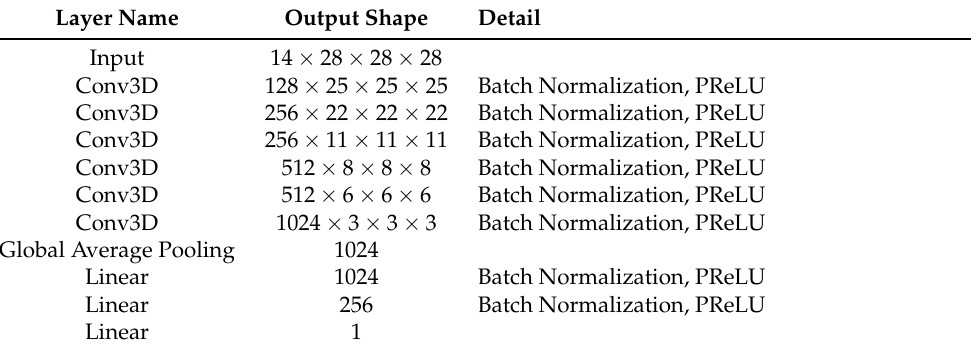
Table A2. Neural network architecture of Sato-3DCNN.